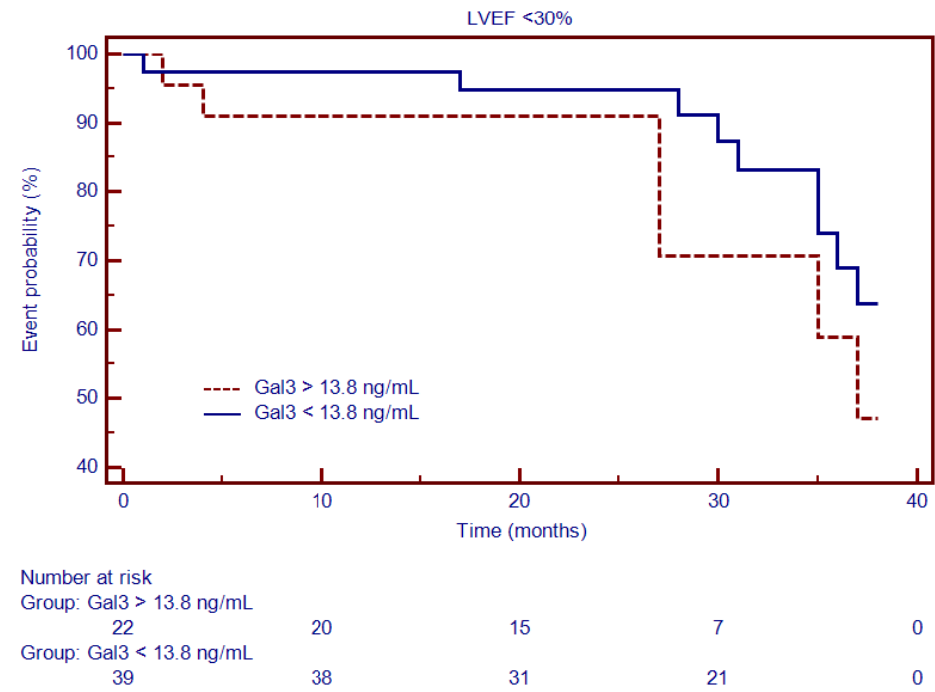
Figure 8. Kaplan–Meier analysis for the ability of Gal-3 to predict cardiovascular outcome in patients with NIDCM and severely decreased LVEF <30%. Abbreviations: Gal-3, galectin-3.